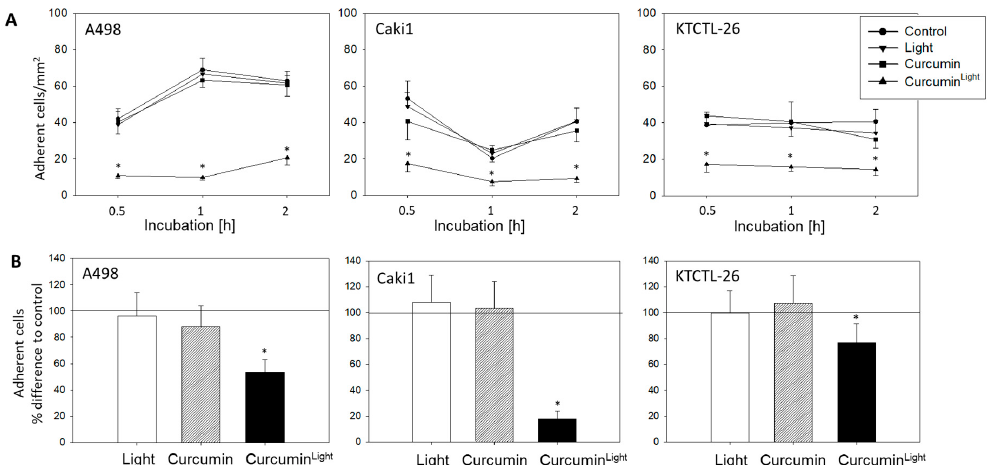
Figure 3. Influence of curcumin (0.2 µg/mL), light, or curcumin Light on adhesion of RCC cells to HU- VECs ( A ) and ( B ) collagen. Five separate fields of 0.25 mm 2 were counted at 200× magnification (means ± SD, n = 6). Control was added cell medium and is indicated by the line at 100% in ( B ). * indicates significant difference to controls ( p = 0.00512).